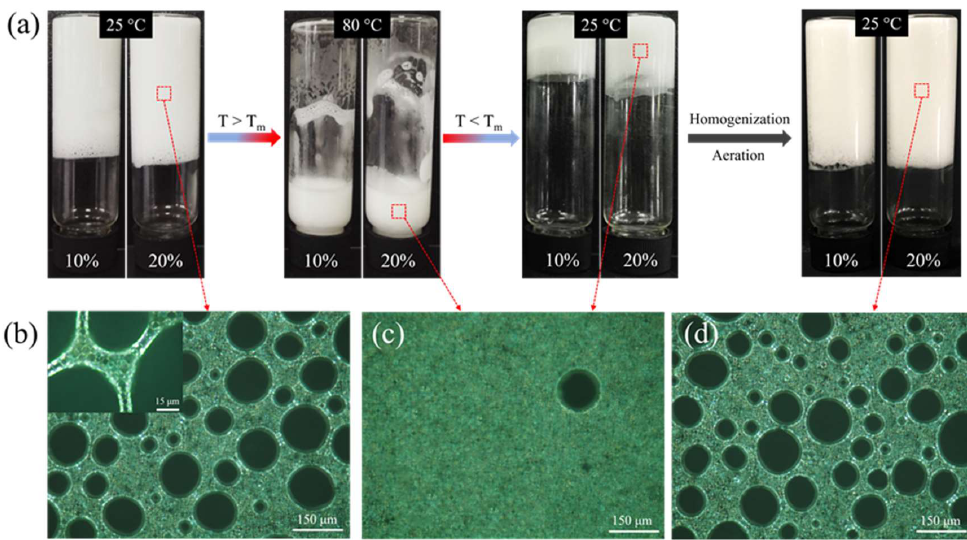
Figure 6. ( a ) Photographs showing the temperature-switchable process for complex emulsion foams containing 10 and 20 wt% oils stabilized by 4 wt% GA nanofibrils. Stable emulsion foams can again be obtained after homogenizing and aerating the mixtures ( c ) at 80 °C followed by cooling in an ice bath. ( b – d ) PLM images of the above samples with 20 wt% oil during the temperature-switchable process. Inset PLM image shows the jamming of the oil droplets in the liquid channels as well as around the bubbles. Images were reproduced with permission from [36]. Table 1. Overview of applications of Quillaja saponin (QS) in colloidal multiphase food systems. Type of Multiphase